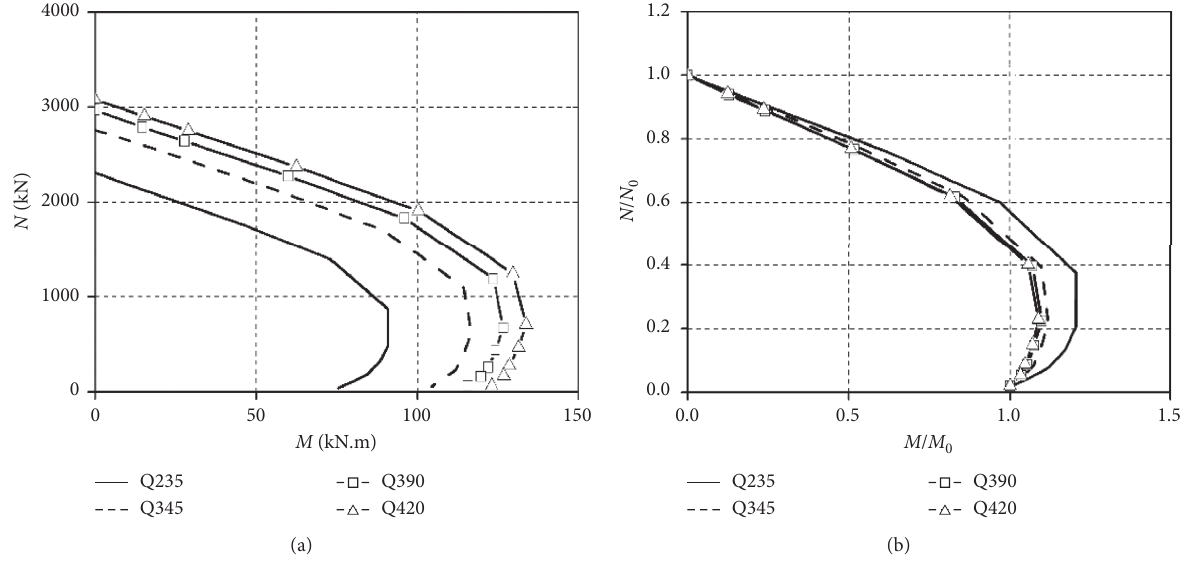
y on the resistance correlation curves. (a) Forward loading. (b) Forward loading